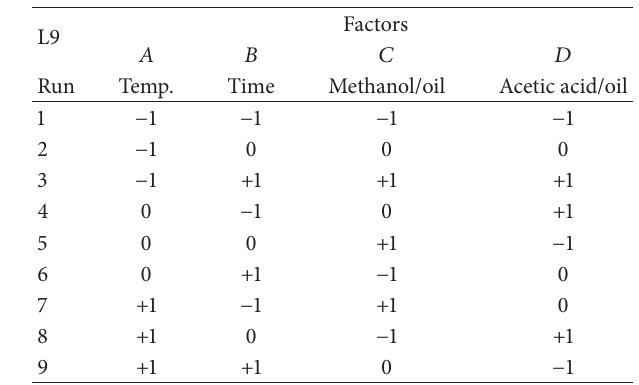
Table 1: Experimental plan by the L9 Taguchi design applied to biodiesel production.